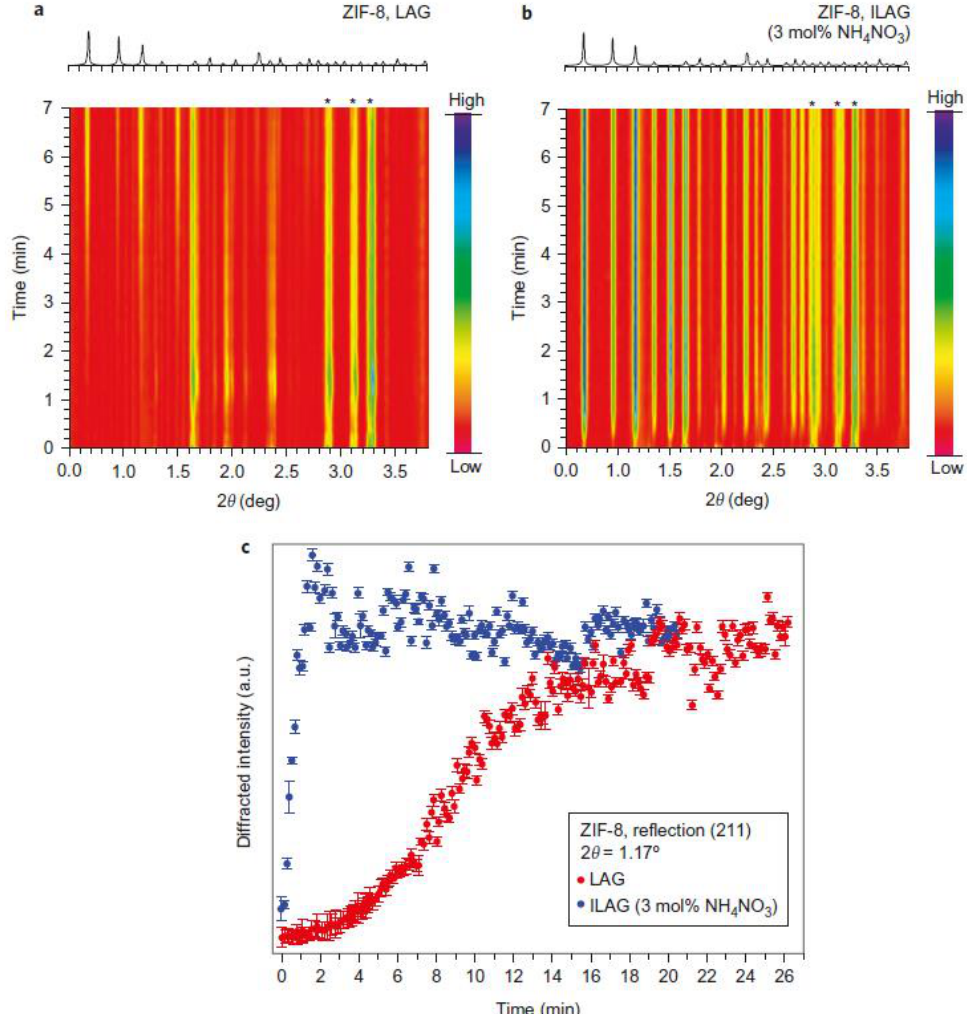
Figure 2. Time-resolved in situ XRD patterns monitoring the mechanochemical synthesis of ZIF-8 framework: ( a ) synthesis using LAG with DMF, ( b ) synthesis using ILAG with NH 4 NO 3 . ( c ) Time- dependent intensity changes of the strongest reflection of ZIF-8 synthesized in the LAG (red) and ILAG (blue) reactions. Reprinted with permission from [46]. Copyright 2012, Springer Nature.